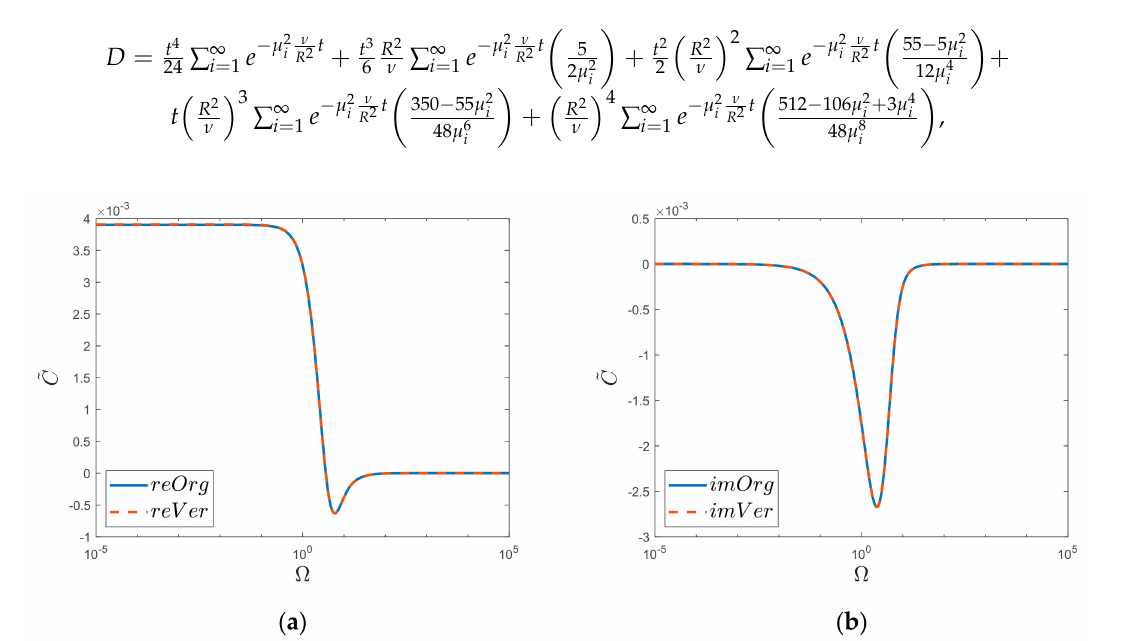
Figure 7. Realis ( a ) and Imaginaris ( b ) graphs of original function “Org” and newly derived substitute “Ver” . Semi − log scale for k = 4